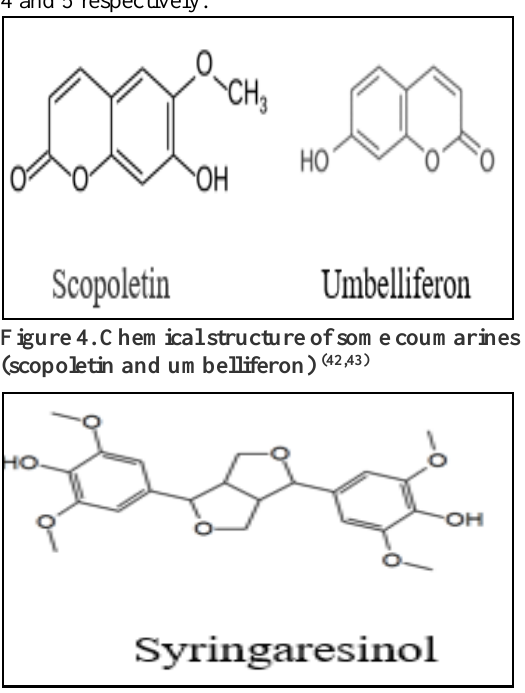
Figure 5. Chemical structure of syringaresinol (lignin) (44) . Using GC/MS